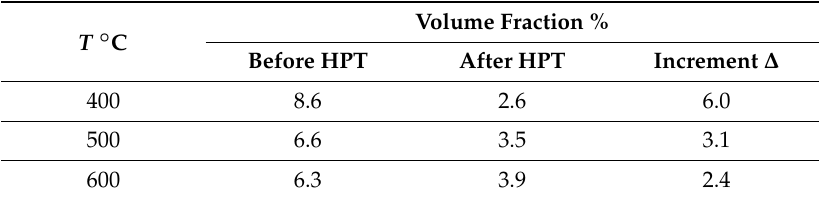
Table 1. The volume fraction (%) of β -phase precipitates in the Cu–8wt.%Ag alloy after annealing at different temperatures T ( ◦ C) measured on the bases of XRD data.